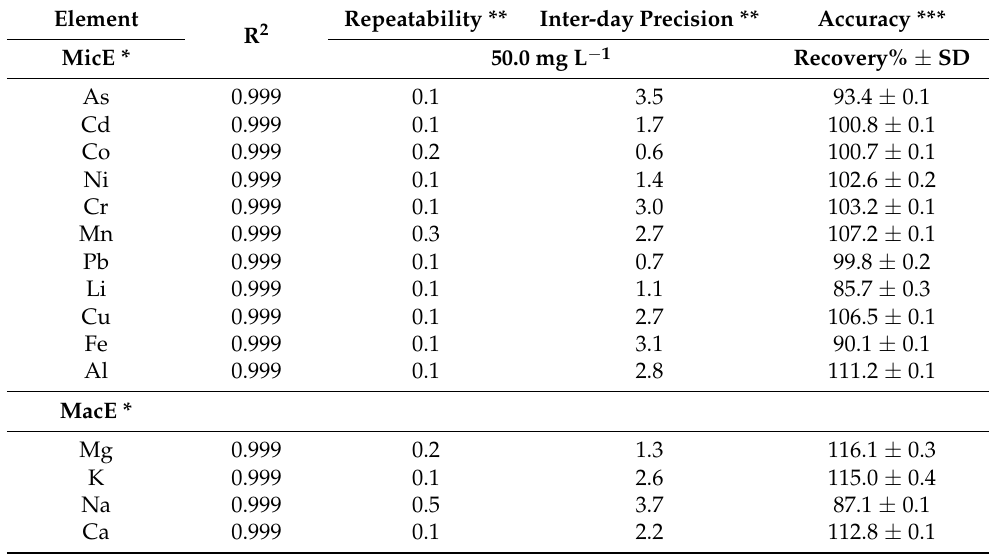
Table 3. Validation data for the determination of elements in herbal weight loss preparations.